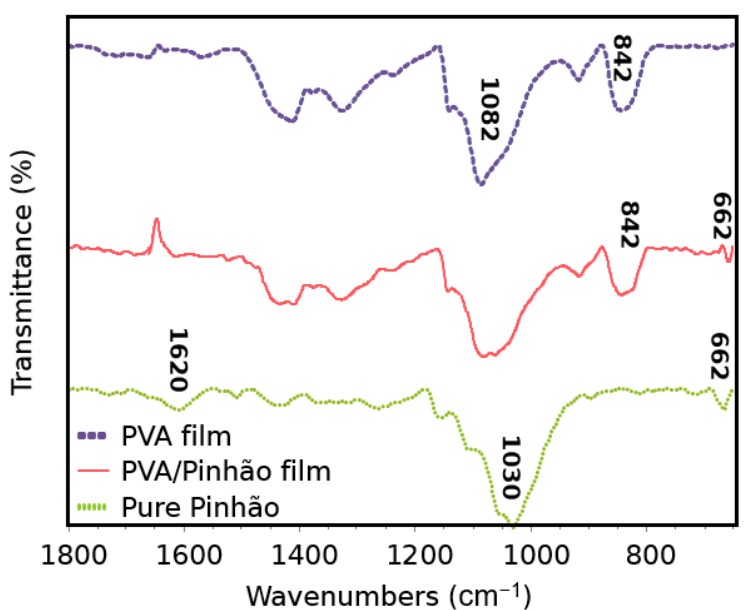
Figure 3. FTIR for PVA film, PVA/Pinhão film and Pinhão pure